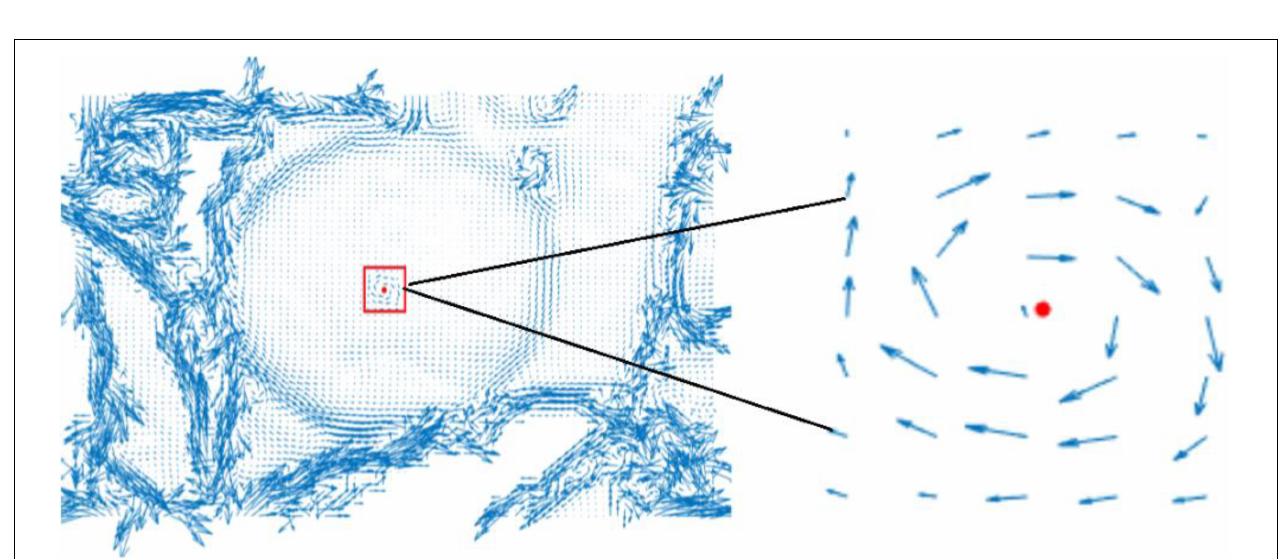
FIGURE 5 | Location of target fruits circle center (gradient vectors are uniformly rotated 90 ◦ clockwise).